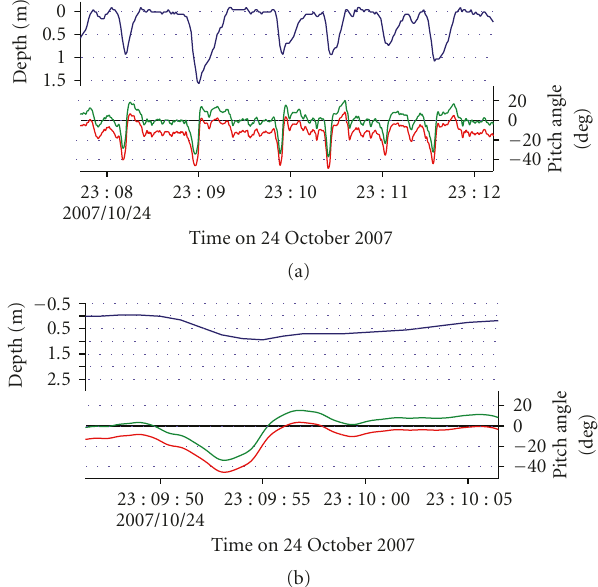
Figure 2: (a) An example of swimming depth (blue line) adjusted pitch angle by new method (green line) and by previous method (red line) of an individual pup (HI0703). (b) Enlarged part of Figure 2 shows that the adjusted pitch angle (green line) changed from a negative to positive value at the moment of